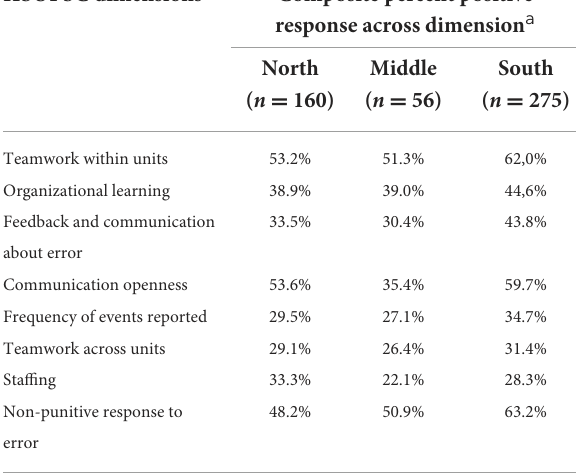
TABLE 4 Composite percent positive responses of HSOPSC dimensions divided by